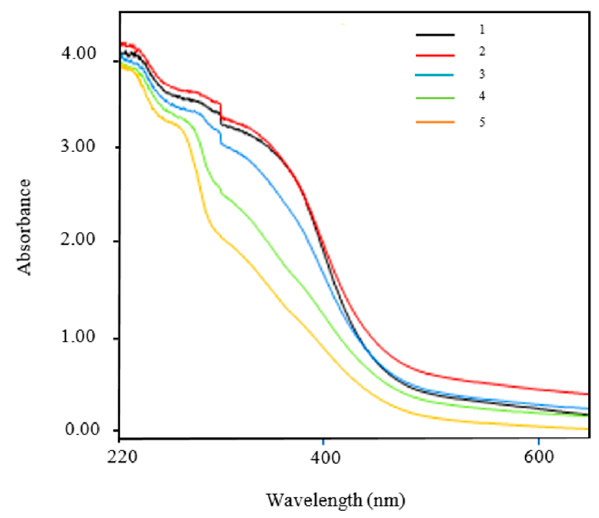
Figure 4. Each maturity class seed steeping solution (20 ml / g seed) ultra-violet (UV) absorbance spectrum.